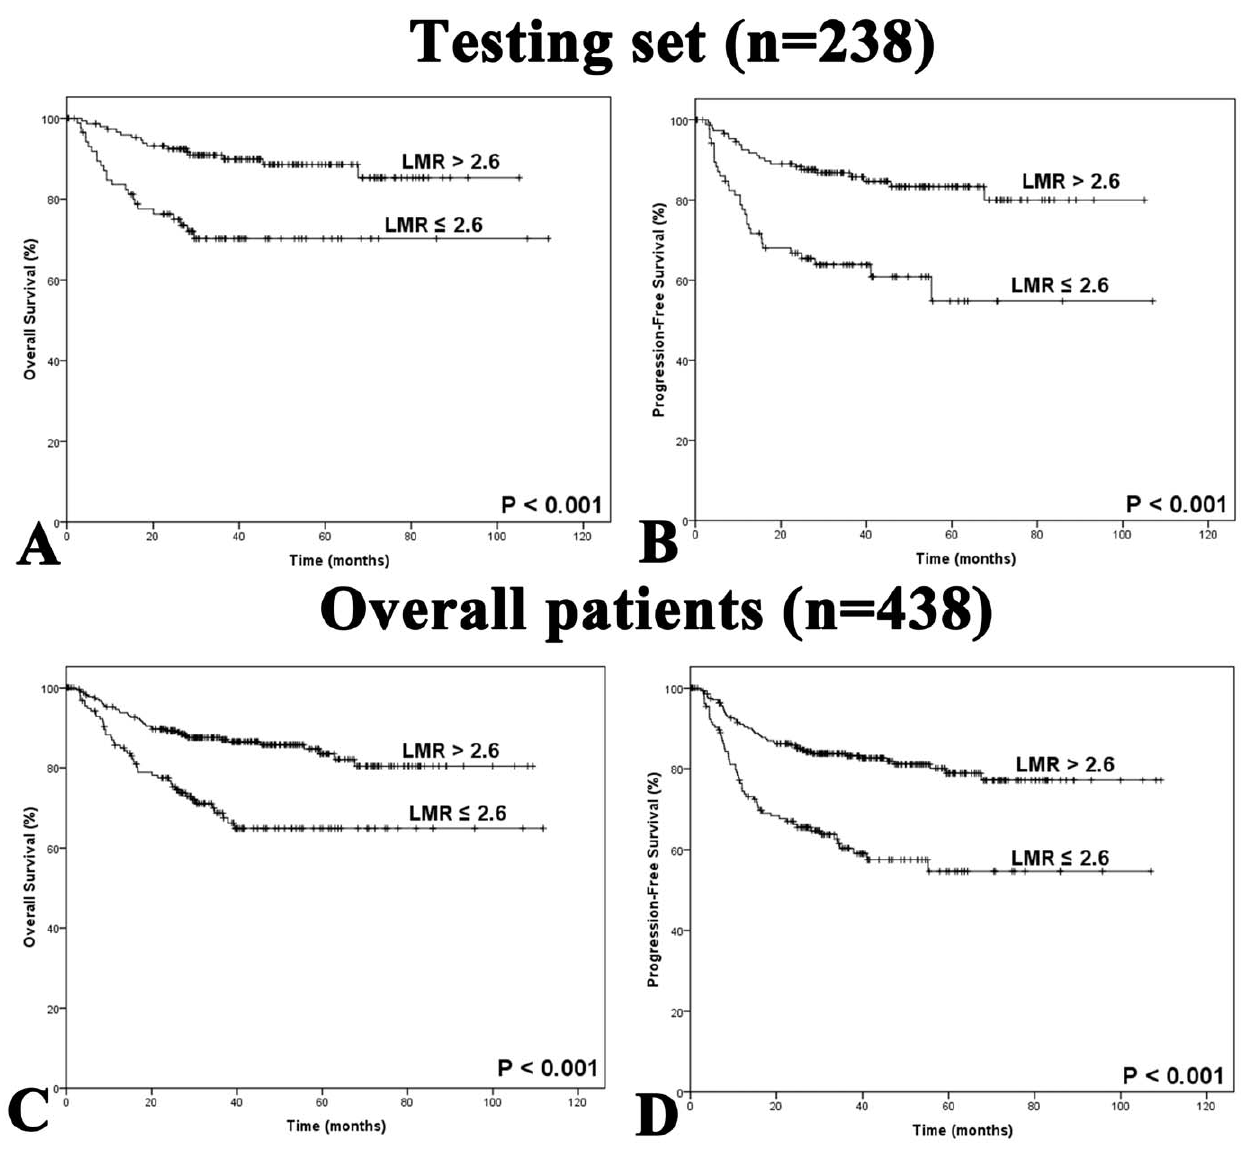
Figure 2. Kaplan-Meier survival analysis of LMR at diagnosis in patients with diffuse large B-cell lymphoma. A: Overall survival according to baseline LMR in the testing set. B: Progression-free survival according to baseline LMR in the testing set. C: Overall survival according to baseline LMR in all patients. D: Progression-free survival according to baseline LMR in all patients. LMR, lymphocyte-to-monocyte ratio.